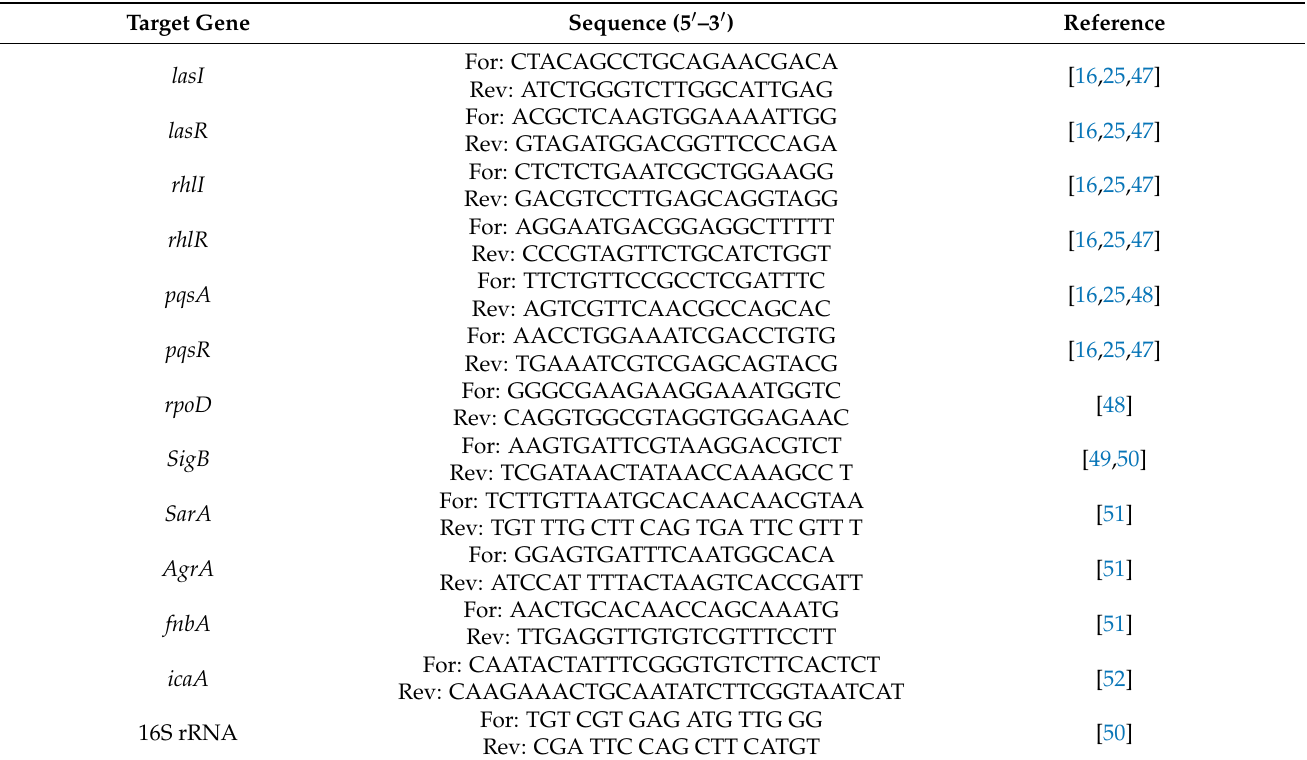
Table 1. Sequences of the used primers for tested